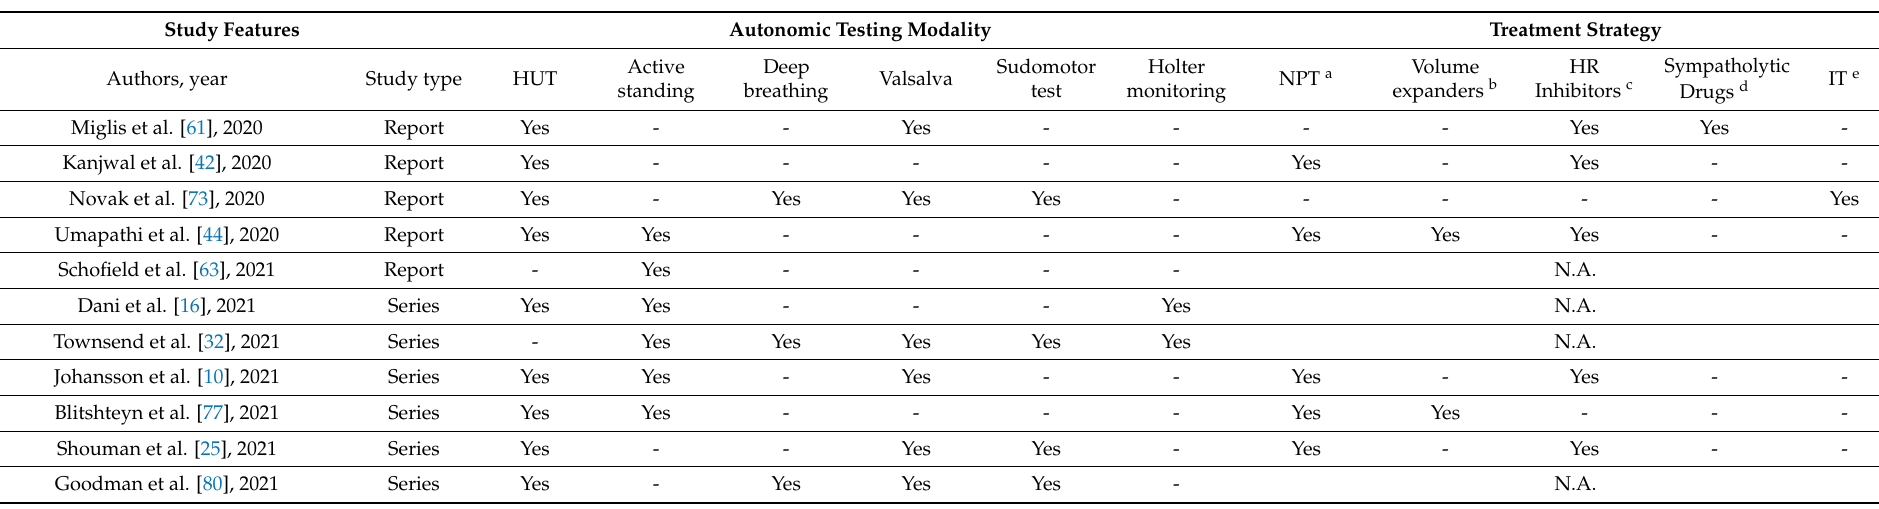
Table 3. COVID-19 related CVAD: overview of diagnostic modalities and strategies of